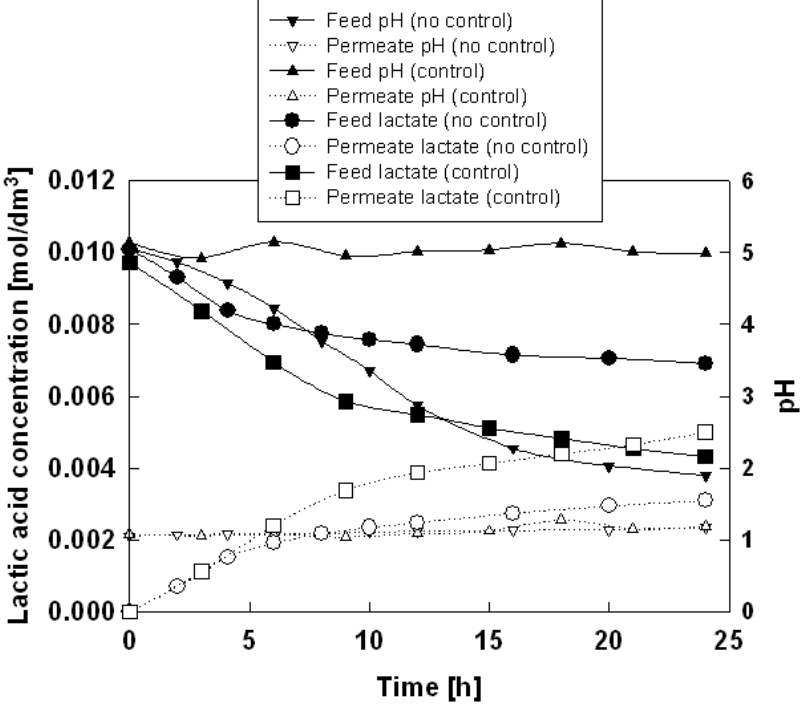
Figure 2. Time change of lactic acid concentration and pH for Ionic liquid Aliquat 336 in the absence and presence of pH control of feed phase.